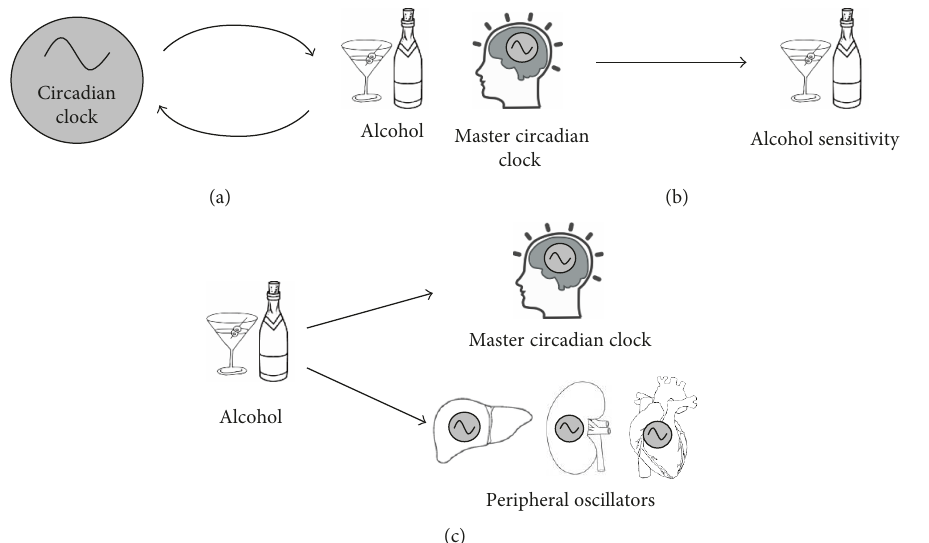
Figure 2: The bidirectional relationship between the circadian clock and alcohol. (a) The circadian clock modulates alcohol sensitivity and alcohol consumption. Alcohol acts upon circadian oscillators to a ff ect phase shifting of oscillators as well as expression patterns of circadian genes leading to circadian dysfunction. (b) The master circadian clock in the brain modulates the behavioral sensitivity to alcohol including hyperactivity, sedation, recovery, and tolerance. (c) Alcohol a ff ects the master circadian clock in the SCN as well as in peripheral oscillators in the liver, kidney, and